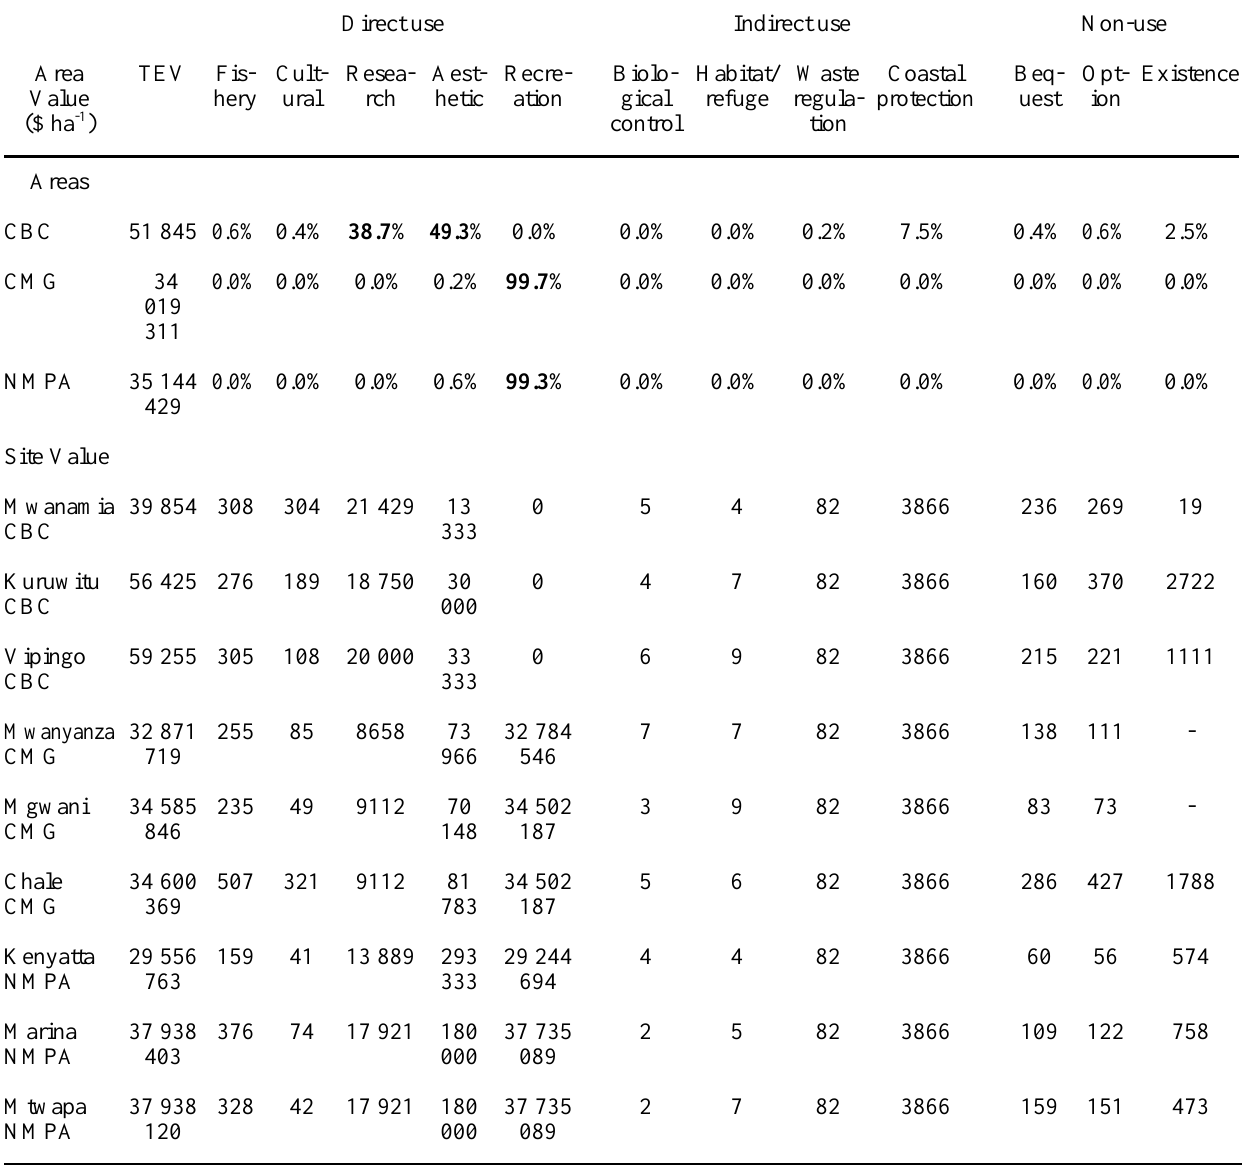
Table 1. Site-level goods and services mean values in $ ha -1 yr -1 . Percent contribution for each good or service is shown aggregated at the management level. Numbers in bold indicate a good or service driving the total economic value in that management